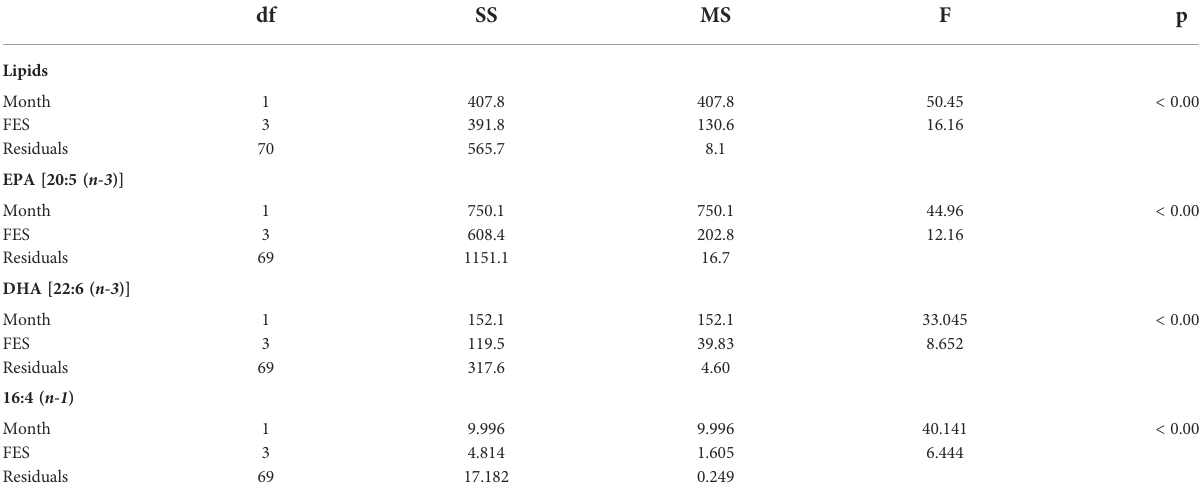
TABLE 5 Analysis of covariance (ANCOVA) statistics for total lipids (% dry mass), eicosapentaenoic acid (EPA; µg mg -1 ), docosahexaenoic acid (DHA; µg mg -1 ) and 16:4 ( n-1 ) (µg mg -1 ). df SS MS F p